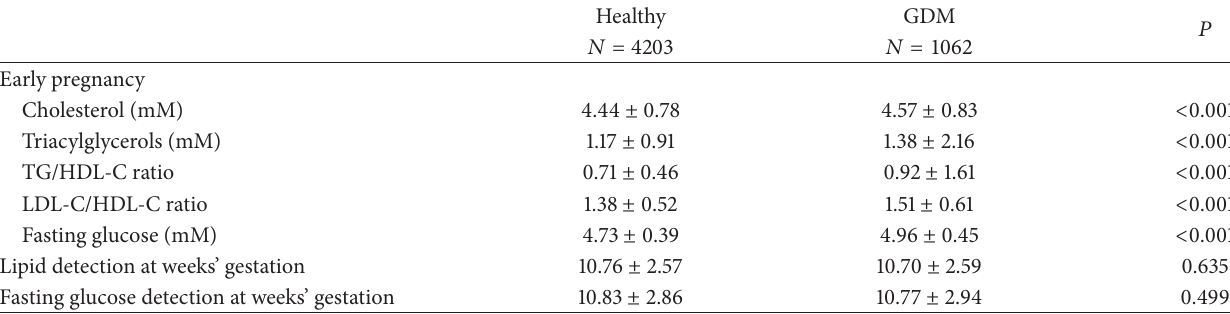
Table 2: Maternal early pregnancy fasting glucose and lipid profiles.